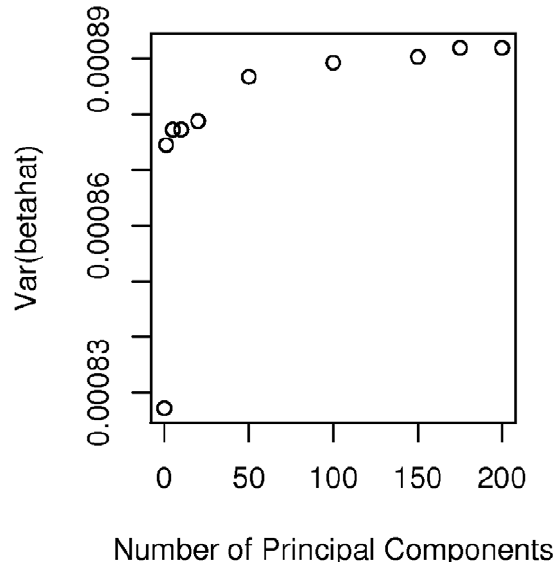
Figure 5. Plot of variance. Plot of the variance of ^ bb 2 according to the number, ‘ , of eigenvectors adjusted for in the Bourgain test of association.